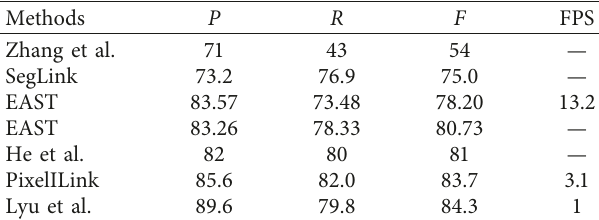
Table 8: Results on the ICDAR2015 dataset.